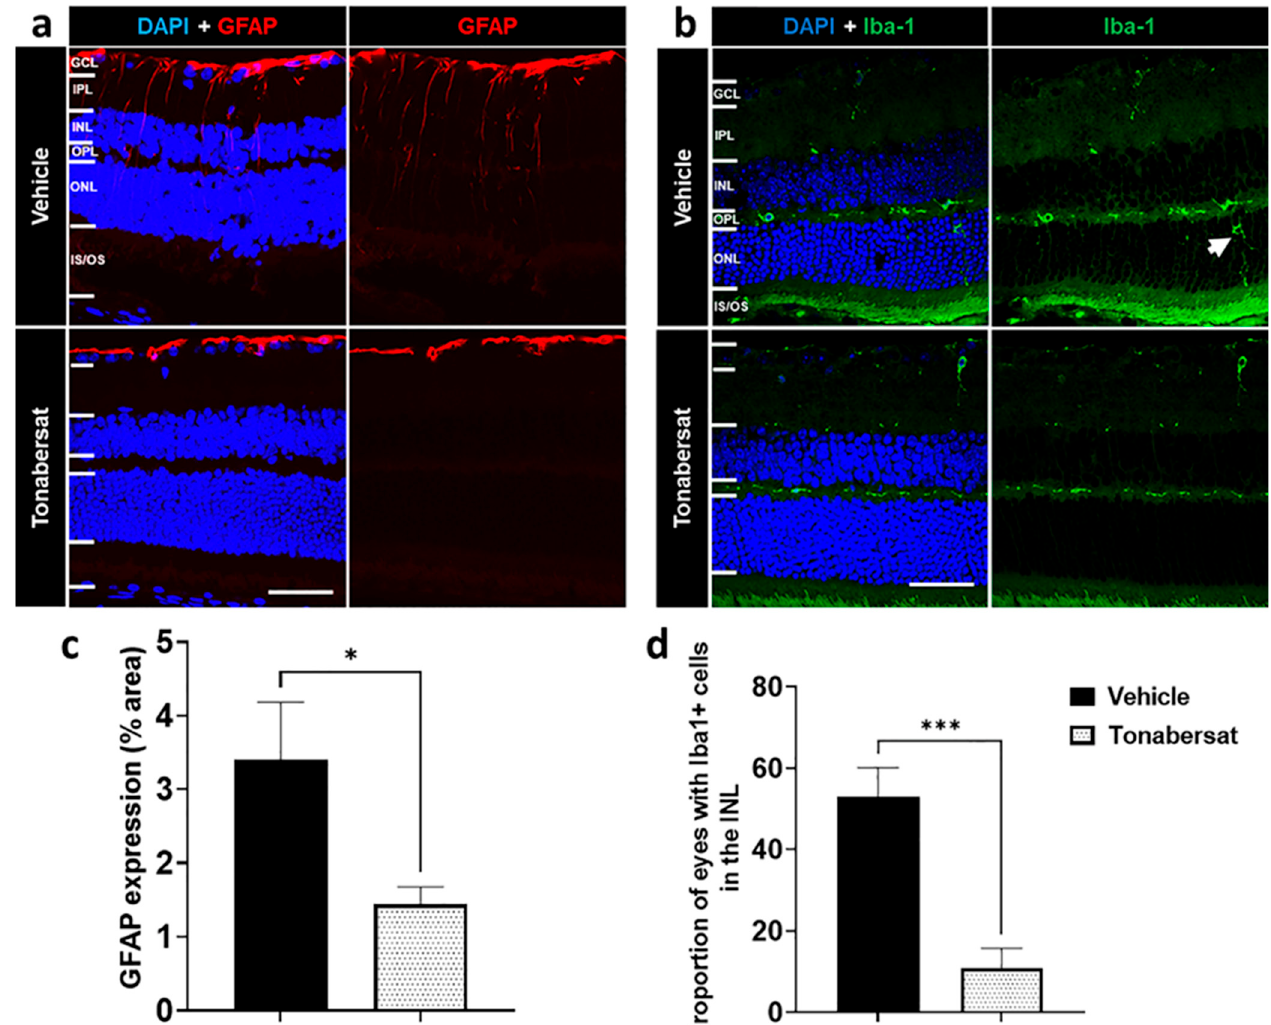
Figure 5. Immunohistochemical images showing ( a ) GFAP and ( b ) Iba-1 in vehicle and tonabersat- treated groups. ( a ) GFAP expression was restricted to the GCL in the tonabersat group but spanned from the GCL to the ONL in the vehicle group. ( b ) Vehicle alone led to migration of Iba-1+ cells into the ONL while tonabersat treatment restricted Iba-1+ cells to the IPL and OPL. The arrow indicates an Iba1 positive cell (activated microglia cell). Tonabersat treatment significantly decreased ( c ) overall GFAP levels and ( d ) the proportion of eyes with Iba-1+ cells in the INL. NFL = nerve fibre layer; GCL = ganglion cell layer; IPL = inner plexiform layer; INL = inner nuclear layer; OPL = outer plexiform layer; ONL = outer nuclear layer. Data are presented as a mean + SEM. Statistical analyses were carried out using a Student’s t -test. * p ≤ 0.05, *** p ≤ 0.001. Scale bar = 50 µ m. n = 812 eyes per